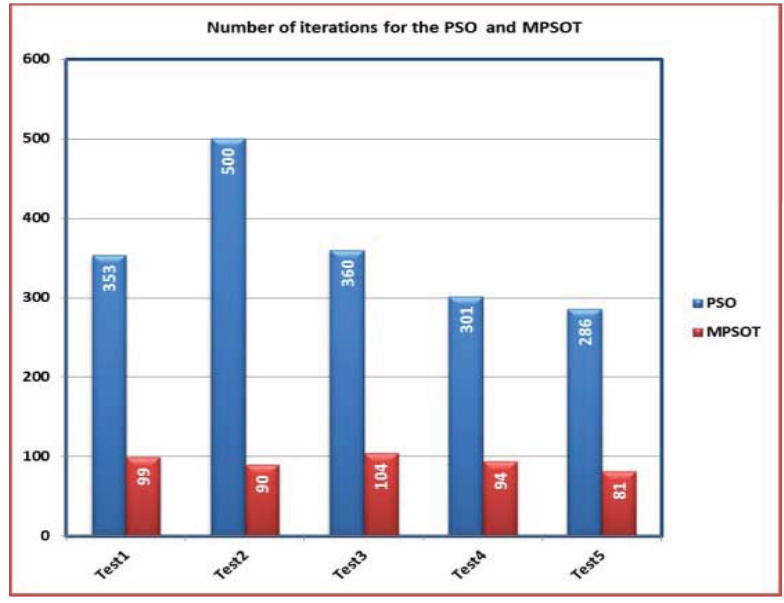
Figure 8. A comparison between the numbers of iterations in case of using the basic PSO and MPSOT in 2-D calibration.